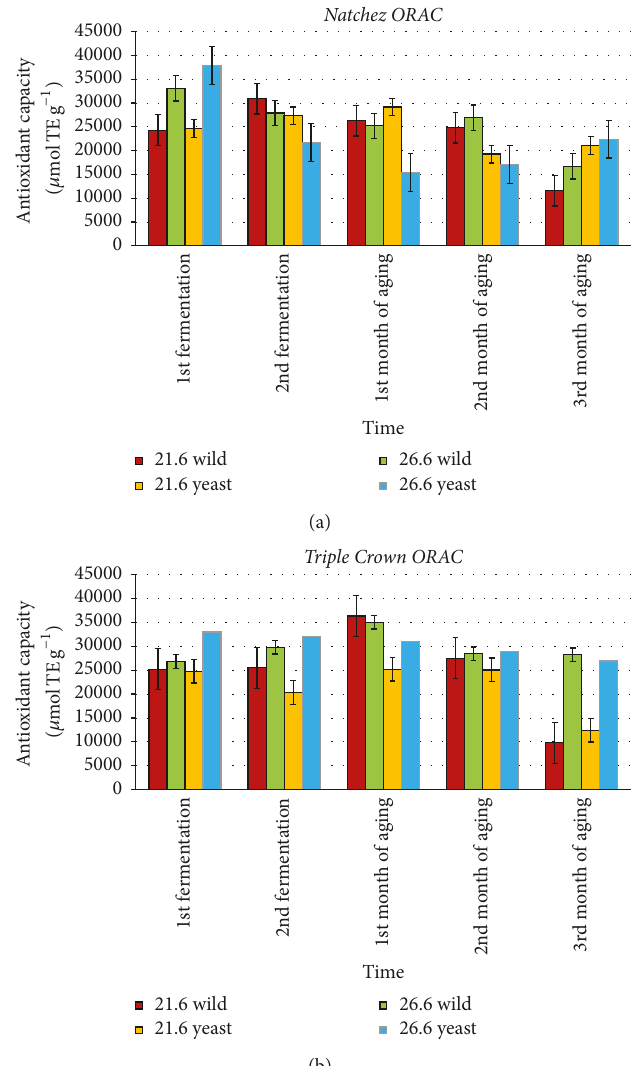
(b) Figure 4: Oxygen radical absorbance capacity ( 𝑁 = 120 ) of “Natchez” blackberry (a) “Triple Crown” blackberry (b) fermented juices and wines. Error bars represent ± standard deviation of the mean ( 𝑛 = 2 ). Table 3: Mean ORAC values for blackberry pomace ( 𝑛 = 3 ). 𝑁 = 24 . a Means with a and b letters indicate significant differences between cultivars within fermentation temperature and inoculation treatment ( 𝑝 < 0.05 ). b Means with c and d letters indicate significant differences between fermentation temperatures within cultivar and inoculation treatment ( 𝑝 < 0.05 ). c Means with e and f letters indicate significant differences between inoculation treatments within cultivar and fermentation temperature ( 𝑝 < 0.05 ). were somewhat higher than those reported in other